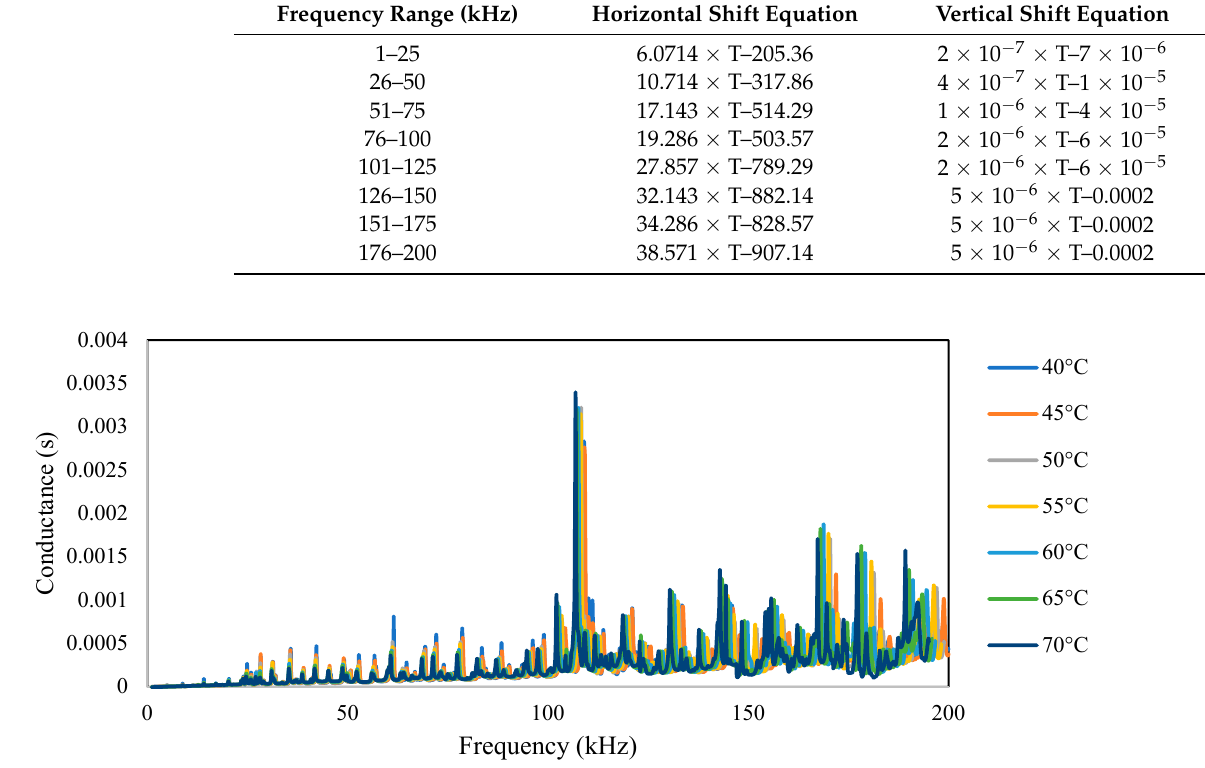
Figure 9. Compensated conductance signature for different temperature.